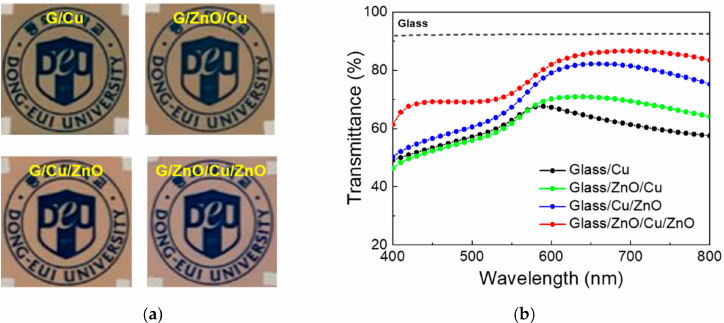
Figure 4. ( a ) Photographs of logos that are placed below the electrode structures of (1) glass / Cu (8 nm), (2) glass / ZnO (30 nm) / Cu (8 nm), (3) glass / Cu (8 nm) / ZnO (40 nm) and (4) glass / ZnO (40 nm) / Cu (8 nm) / ZnO (40 nm), respectively. ( b ) Transmission comparison for the four electrode structures. The air baseline was taken and the transmittance of bare glass is also given as